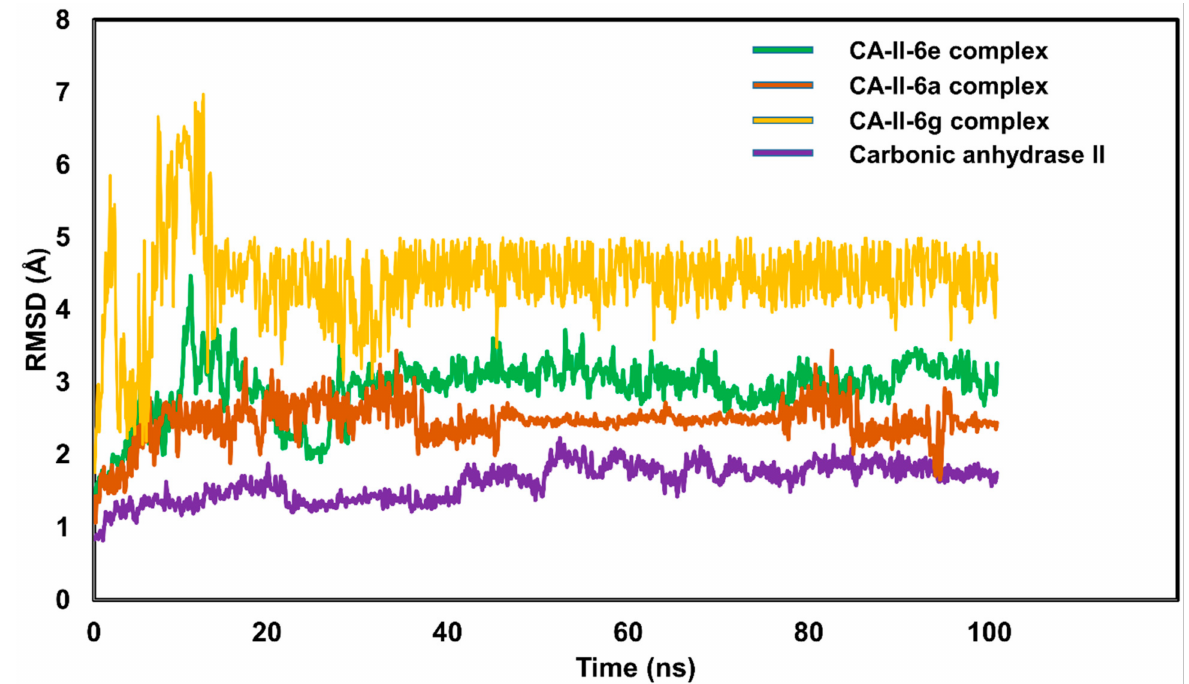
Figure 8. The evolution of RMSD pattern for carbonic anhydrase (CA-II), CA-II- 6e , CA-II- 6a , and CA-II- 6g complexes. The green colored trajectory depicting the RMSD pattern for CA-II-6e com- plex, pale-yellow trajectory for CA-II-6g complex, brown-colored trajectory depicts the evolution of RMSD pattern for CA-II-6a complex, whereas purple-colored trajectory represents RMSD of carbonic anhydrase II.